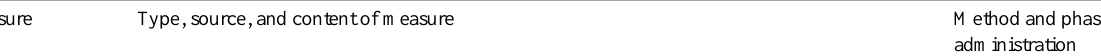
Table 2. Measures used in the treatment-as-usual (TAU), intervention, and postintervention phase. GP